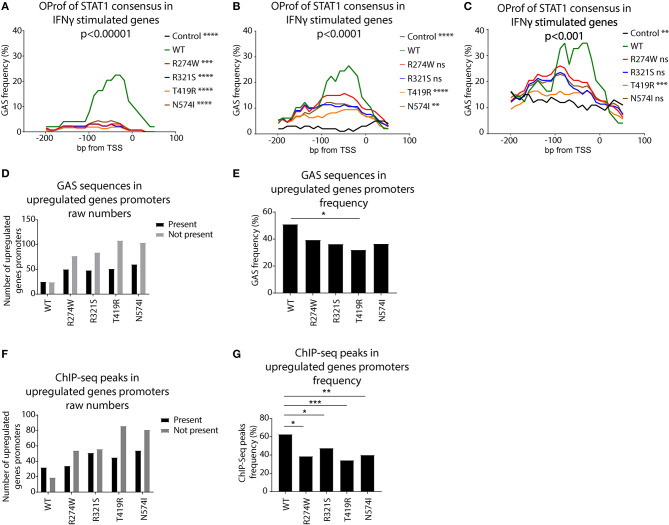
Occurrence profile (OProf) of IFNγ activation site (GAS) consensus sequences, predicted using the HOCOMOCO (34) GAS consensus at three different p-value thresholds for genes up-regulated upon IFNγ stimulation: (A)
p < 0.00001, (B)
p < 0.0001, and (C)
p < 0.001. As control, we used promoter sequences from 100 randomly selected genes. Statistics (A–C): Friedman test with Dunn's multiple comparison post-hoc test was performed comparing each group to STAT1 WT; ns not significant; **p < 0.01; ***p < 0.001; ****p < 0.0001. (D) Number of promoters containing GAS consensus occurrence in promoters of genes up-regulated upon IFNγ stimulation. Black bars show promoters containing at least one GAS consensus sequence, gray bars (E) Frequency of genes harboring at least one GAS consensus in their promoter over the total upregulated genes. (F) Number of promoters containing ChIP-Seq peaks for genes up-regulated upon IFNγ stimulation. Black bars represent promoters containing at least one ChIP-Seq peak. Gray bars show the number of promoters lacking a ChIP-Seq peak. (G) Frequency of genes harboring at least one ChIP-Seq peak in their promoter, over the total upregulated genes. Statistics (D,E): Pearson's Chi-squared test with Yates' continuity correction; *p < 0.05; **p < 0.01; ***p < 0.001. OProf, occurrence profile; GAS, IFNγ activation site.